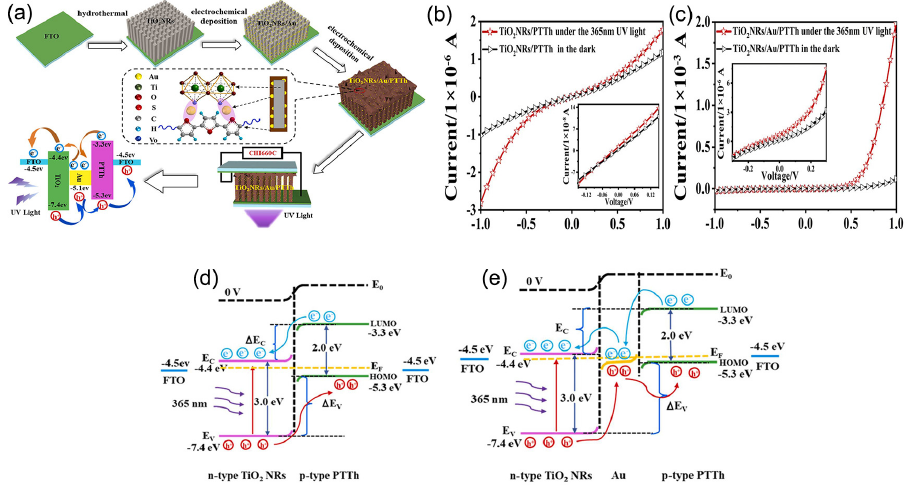
Figure 2. ( a ) Diagram of the preparation and assembly of a self-powered UV detector. Linear ( b , c ). ( d , e ). Self-powered mode of TiO 2 NRs/PTTh and TiO 2 NRs/Au/PTTh heterojunction energy band diagrams. Reproduced with permission from Ref. [11]; published by Elsevier BV, 2022.